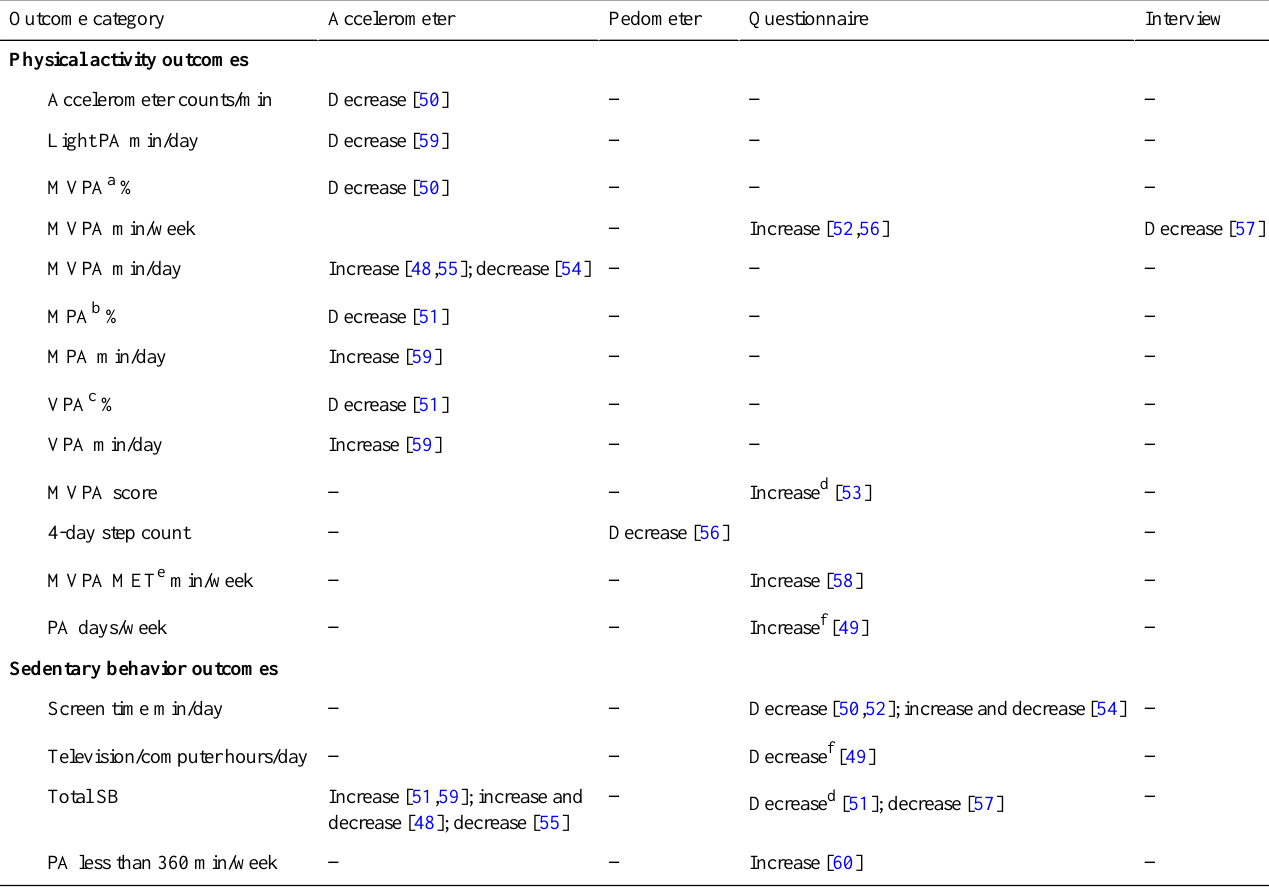
Table 6. Overview of physical activity (PA) and sedentary behavior (SB) outcomes and outcome measures in intervention groups at longest follow-up. InterviewQuestionnairePedometerAccelerometerOutcome category Physical activity